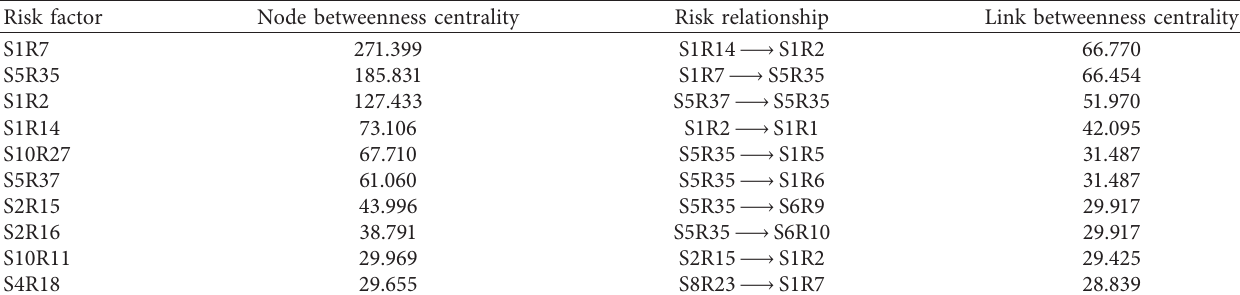
Table 7: Key risk factors and relationships according to betweenness